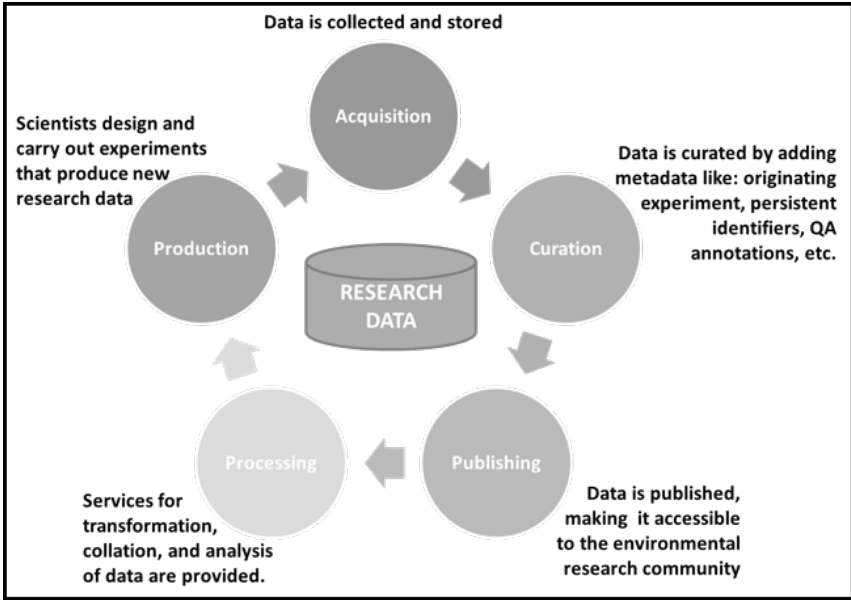
Figure 1. Data management workflow as conceived by the ENVRI